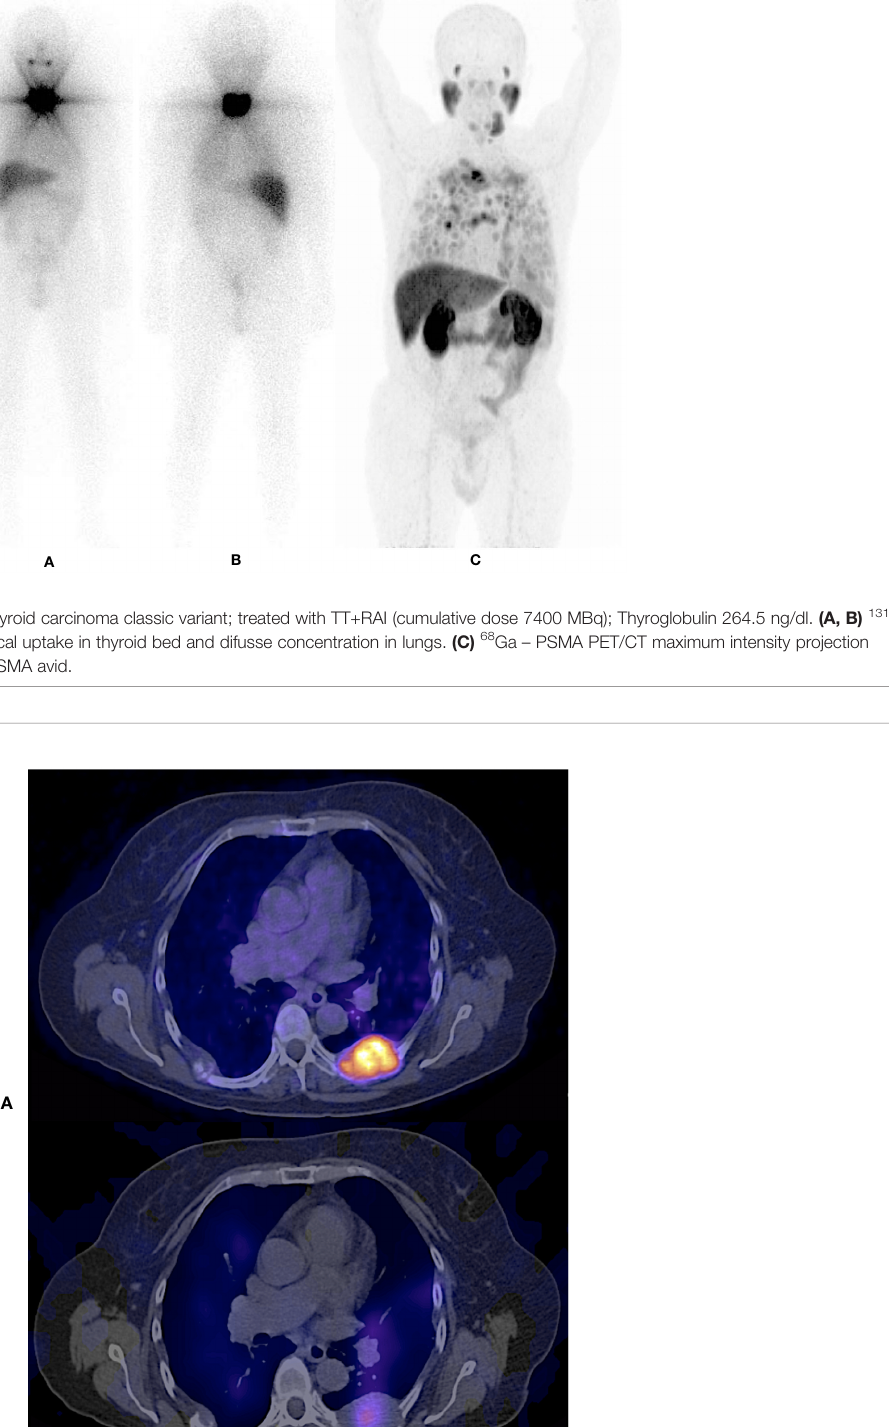
FIGURE 11 | 61 years old female with follicular thyroid carcinoma, insular differentiation (20%), treated with TT + RAI (cumulative dose 25900 MBq); Thyroglobulin 3922 ng/dl. Paravertebral implant. (A) 68 Ga - PSMA PET/CT avid lesion. (B) 131 I – SPECT/CT showed diffuse uptake of the